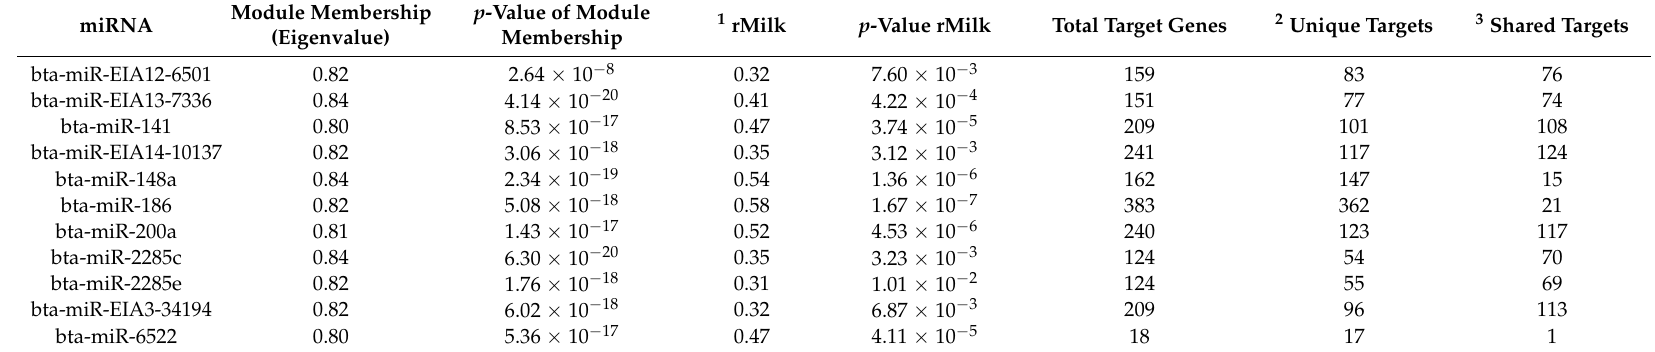
1 rMilk is the Person correlation coefficient between miRNA and milk yield; 2 Gene targets unique to miRNA; 3 Gene targets shared with other miRNAs in the GREEN